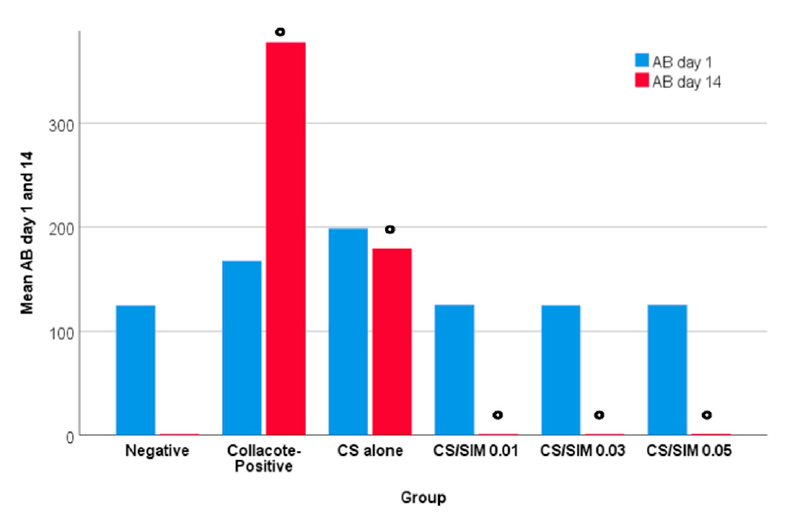
Figure 3. AlamarBlue values indicating cell viability on day 1 and 14. ◦ a significant difference ( p < 0.05). AB, AlamarBlue; CS, chitosan; SIM, simvastatin.